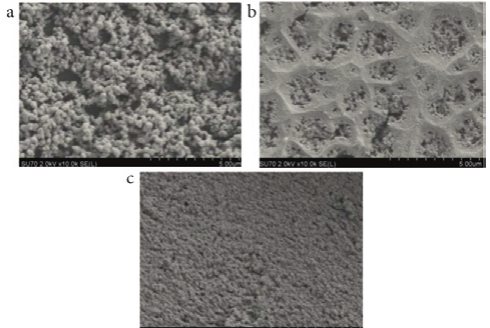
fig. 12. Bitumen structure before short-term aging: a – bitumen of the producer B (Russian crude oil); b – bitumen of the producer C (Venezuelan crude oil); c – polymer-modified bitumen of the producer E (Russian crude